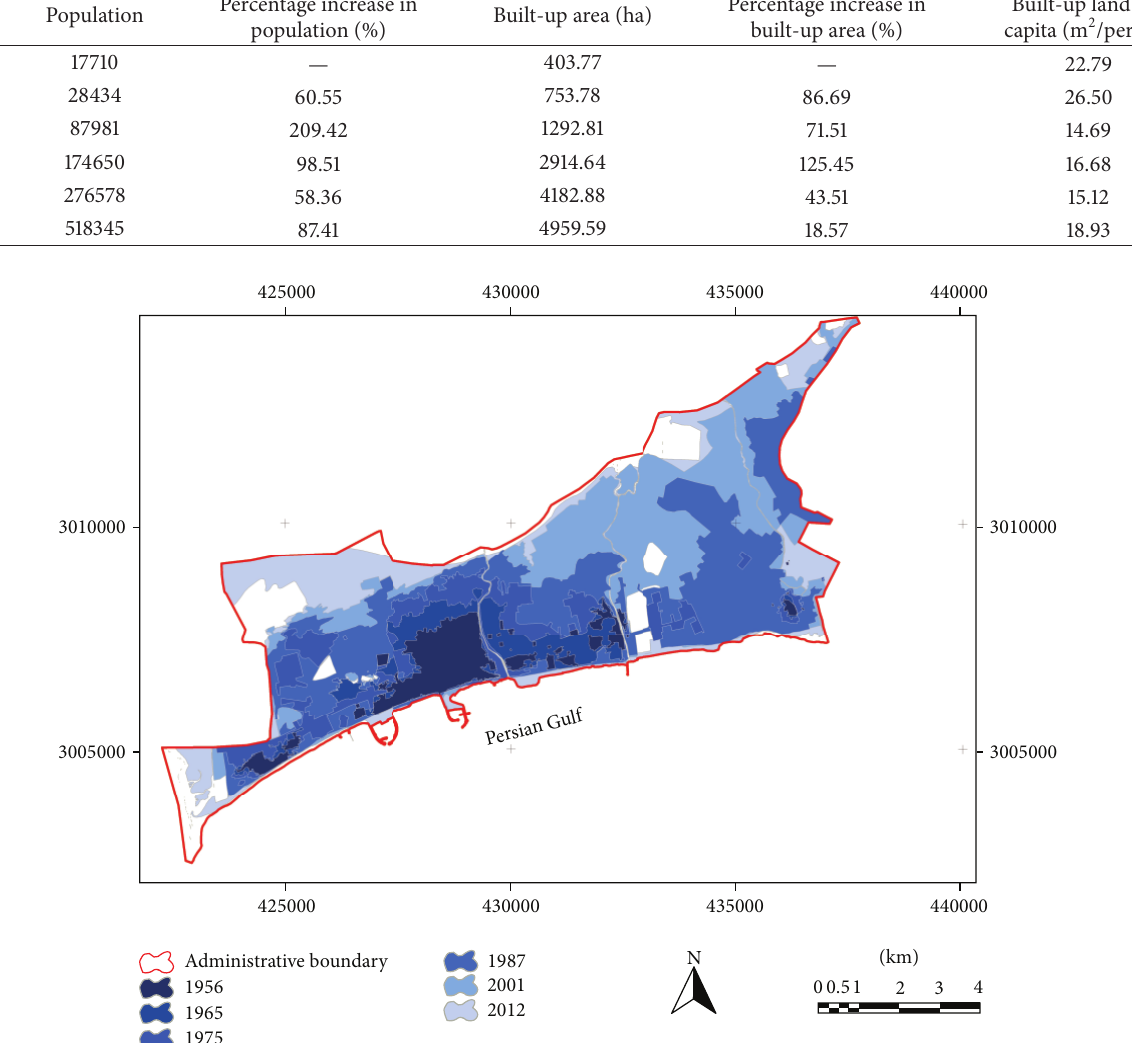
Figure 3: Urban growth and expansion of Bandar Abbas city